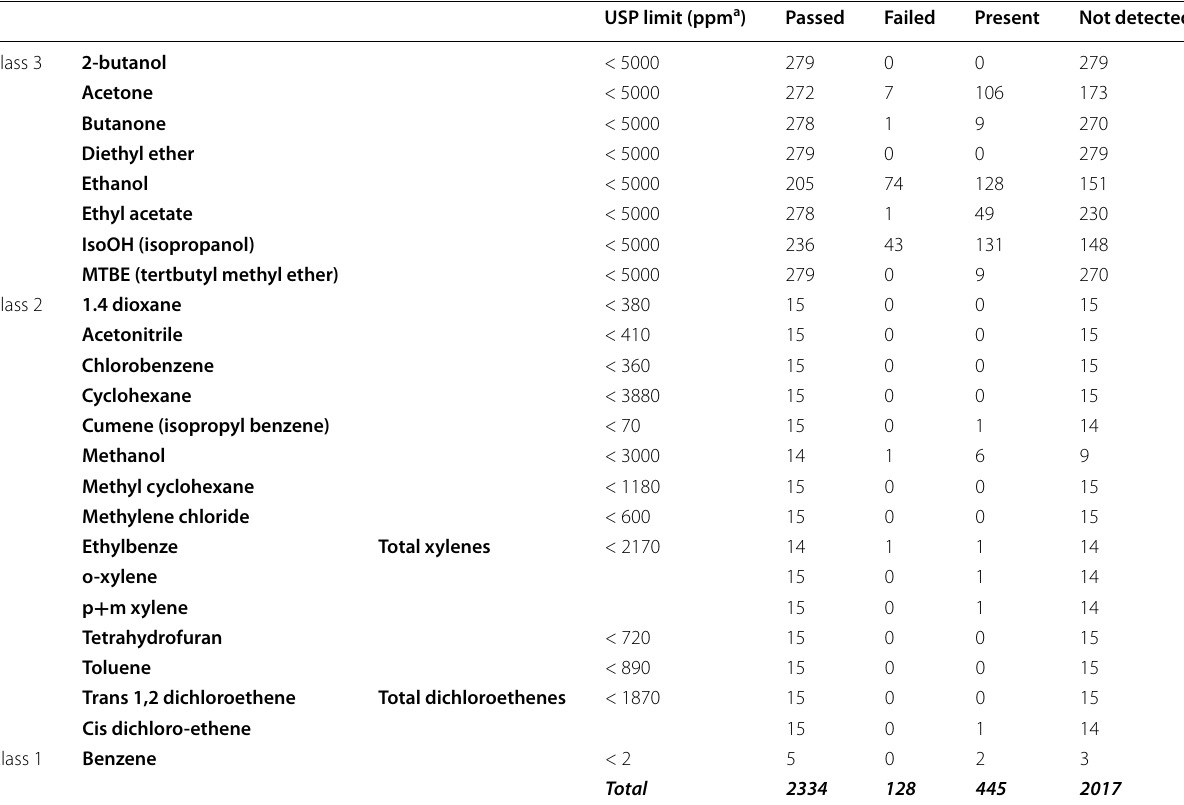
Table 3 Individual solvent failures and occurrence in